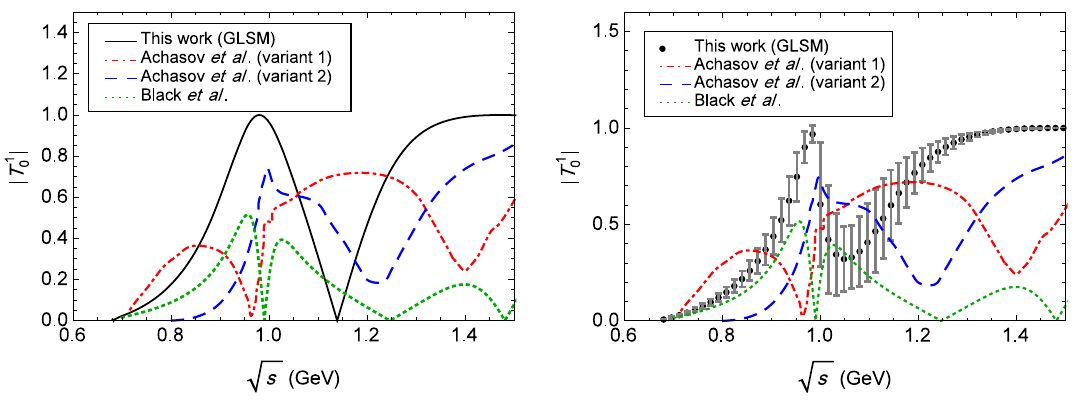
Fig. 10 Comparing the prediction of the GLSM (left) for the modu- lus of T 1 with the predictions by Achasov et al. [150] and by Black 0 et al. [138]. The behavior of “variant 2” of [150] (dashed curve) is qualitatively closer to that of GLSM (with inputs A 3 / A 1 = 30 and m [ π( 1300 ) ] = 1 . 38 GeV). The right figure gives the averages (dots)